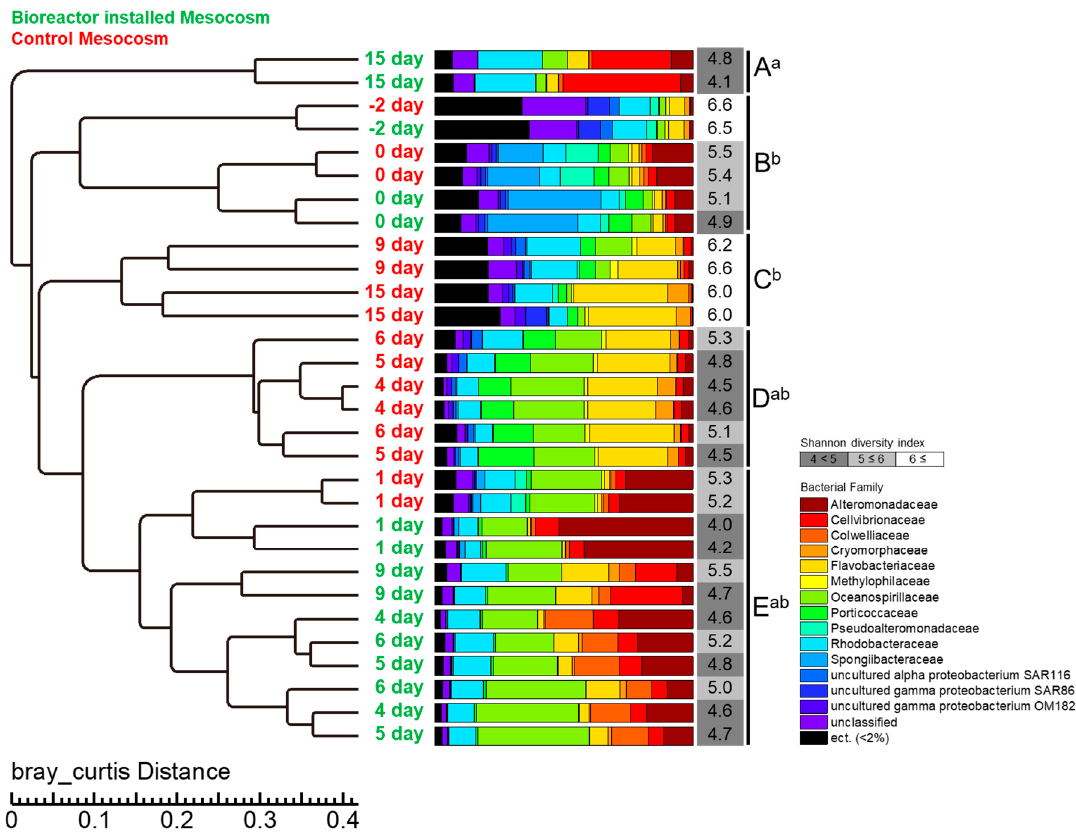
Figure 9. Cluster analysis using Ward’s method for the Bray–Curtis distance for bacterial community structure and the Shannon diversity index of each mesocosm for 15 experimental days. Each component of the clades is marked with green and red colors for the bioreactor installed mesocosm and control mesocosm, respectively. The five clades ( A – E ) were divided into three groups a, b, and ab, according to the average Shannon diversity index of each clade by analysis of variance (ANOVA).